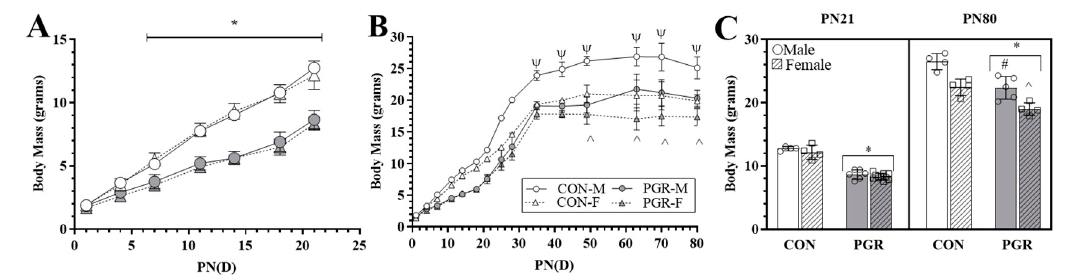
Figure 1. Effects of postnatal growth restriction (PGR) on growth: ( A ) Postnatal Day 1-21 (PN1–PN21) growth rate: PGR significantly (*; p < 0.001) reduced growth rate starting at PN7, with no sex effect, when compared with control (CON). ( B ) PN22–PN80 growth rate: PGR significantly ( p < 0.001) reduced body mass at several time points (PN35, 42, 49, 63, and 70). The Control-Male (CON-M) mass was significantly ( Ψ : p < 0.001) larger than all other groups. There was no significant ( p = 0.967) difference between Control-Females (CON-F) and Postnatal Growth Restricted-Males (PGR-M). From PN49 to PN80, Postnatal Growth Restricted-Females (PGR-F) were significantly reduced compared to CON-F (ˆ: p < 0.01). ( C ) Body mass (PN21 / PN80): PN21-PGR ( n = 16) mass was significantly less (*: p < 0.001) than for the CON group ( n = 8), with no sex effect. PN80-PGR ( n = 9) mass was significantly reduced (*: p < 0.001) compared to the CON group ( n = 8). PGR-M were significantly less than CON-M (#: p < 0.001), and PGR-F were significantly less than CON-F (ˆ: p < 0.01). PGR-M vs. CON-F was non-significant ( p >